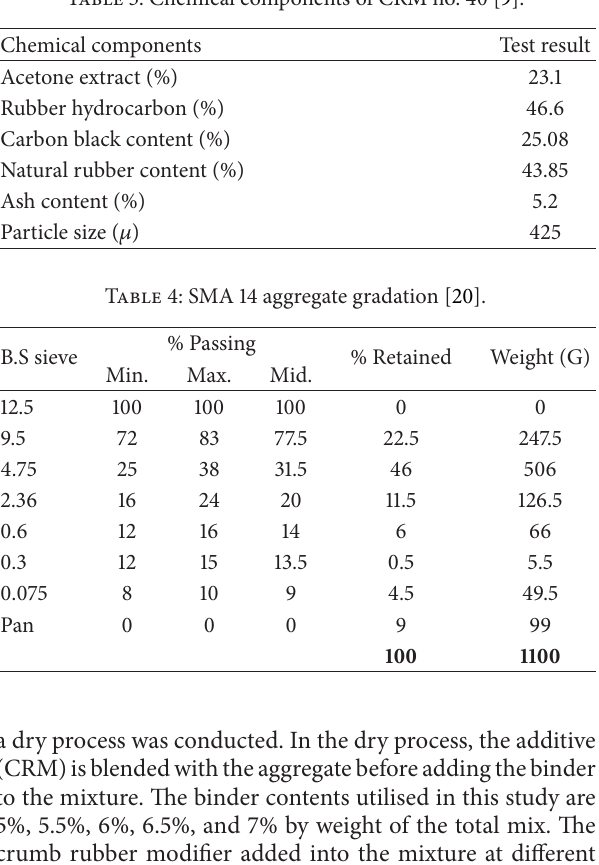
Table 3: Chemical components of CRM no. 40 [9].